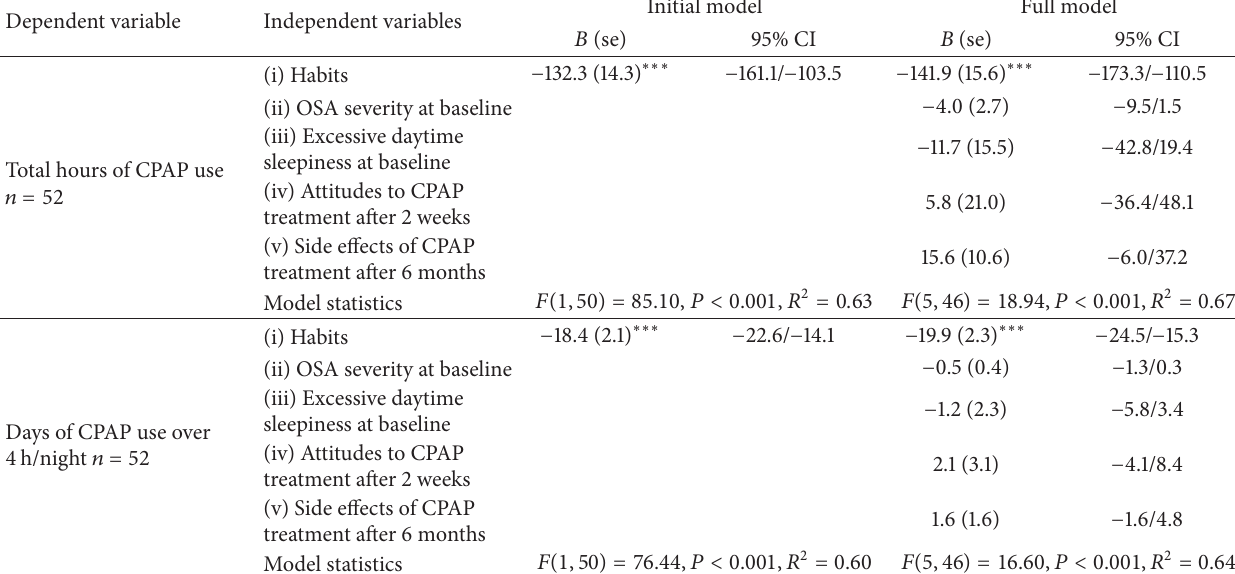
Table 5: The association between habits after 6 months and CPAP adherence at 12 months ( 𝑛 = 52